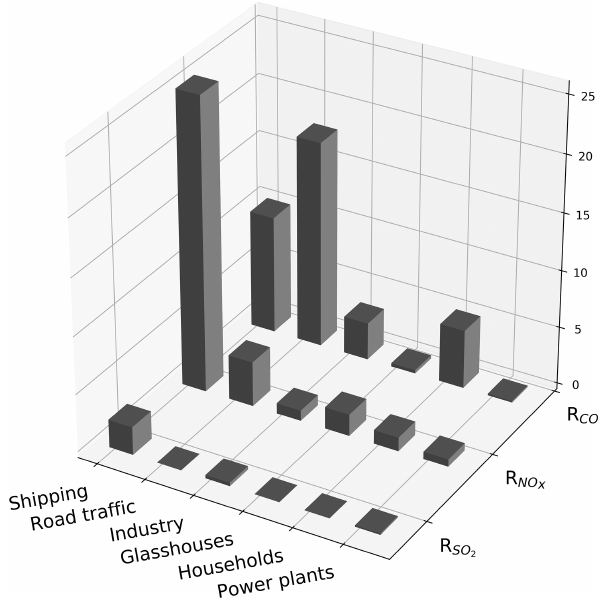
Figure 2. Emission ratios of CO / CO 2 ( R CO ), NO x / CO 2 ( R NO and SO 2 / CO 2 ( R SO ) for specific source sectors based on the 2 Dutch Pollution Release and Transfer Register (Netherlands PRTR, 2014). Units are in parts per billion per parts per million (ppbppm − 1 ). A value of 10 on the y axis thus implies that for each 1000mol of CO 2 10mol of the auxiliary tracer is